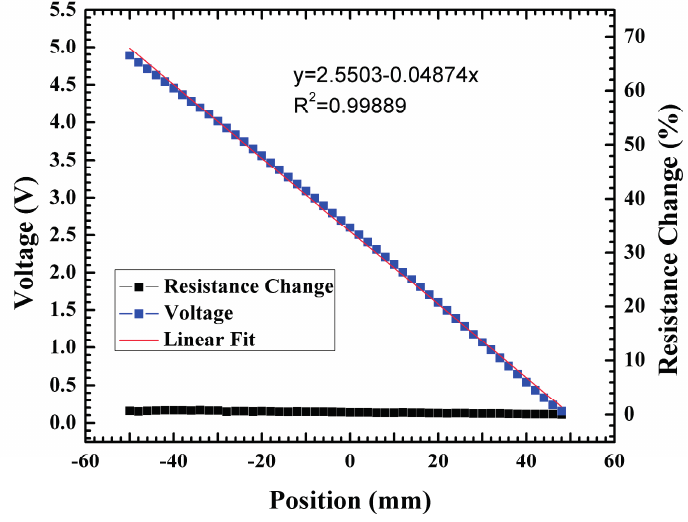
Figure 9. Coordinate plot and resistance change for a 0-to-5 V bias applied to the Ti metal line. The 0-to-5 V bias was then applied to the Au-Ti line. Using this bias condition, a coordinate plot for voltage and resistance change vs. position was measured. It was observed that having a low resistance led to a linear symmetric coordinate plot. The resistance was essentially constant across the device with an overall resistance change of 0.2%. The application of the bias to the device with the lower resistance led to a linear symmetric coordinate plot and a significantly lower resistance change as seen in Figure 10. For greater device lengths (>37 mm), dual metal lines are needed to achieve a linear coordinate plot due to the large non-uniformity in the potential distribution across the floating line that occurs when there is no metal line connecting the contacts.